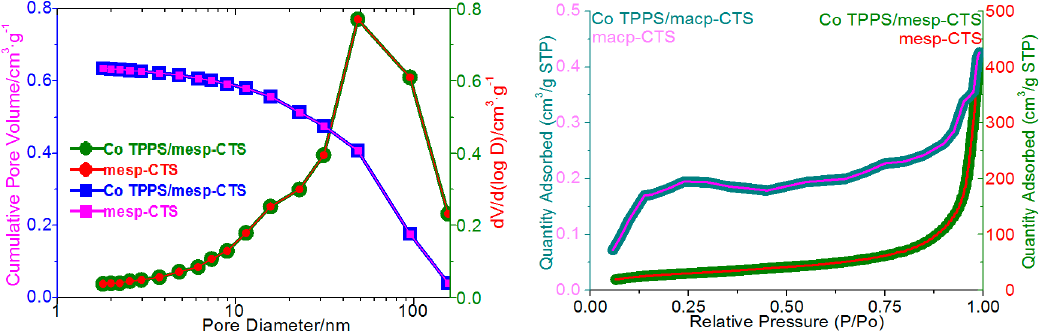
Figure 2. BJH pore-size distribution of Co TPPS/mesp-CTS, mesp-CTS; BET adsorption isothermal plot of Co TPPS/mesp-CTS, mesp-CTS, Co TPPS/macp-CTS and macp-CTS. 1. Physical characteristics of mesoporous chitosan (mesp-CTS) and cobalt tetrakis(p-sulphophenyl)porphyrin chloride(Co TPPS)/mesp-CTS. BET; BJH. Material BET Surface Area